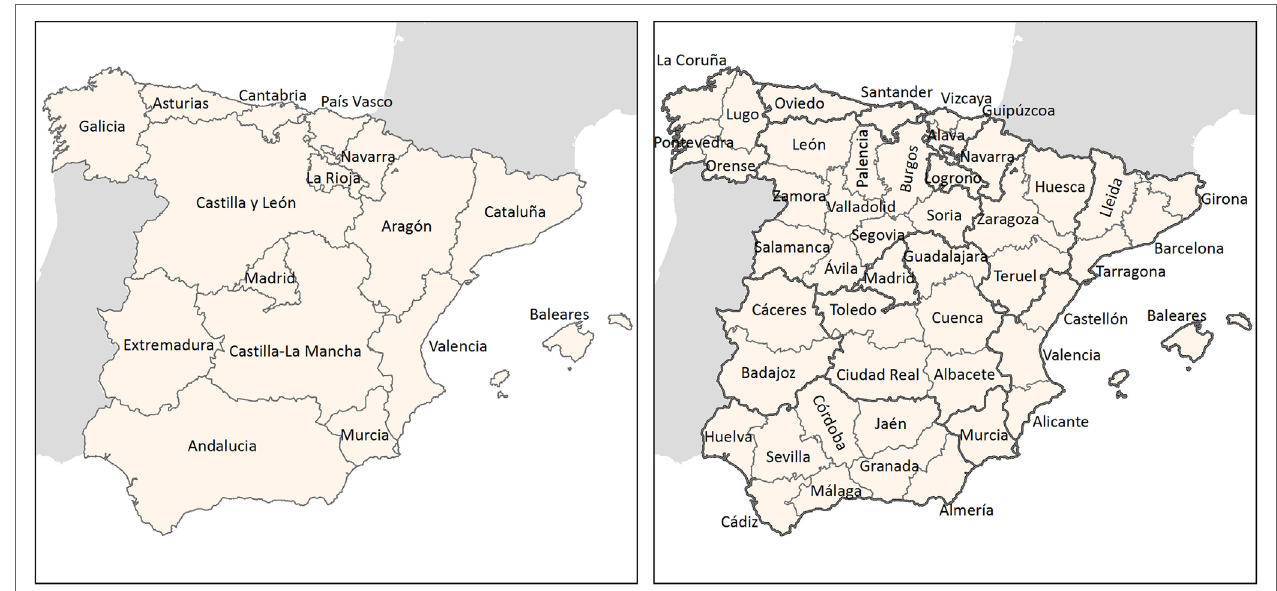
FigUre 3 | Regions and Provinces in Spain. Source: Own research.